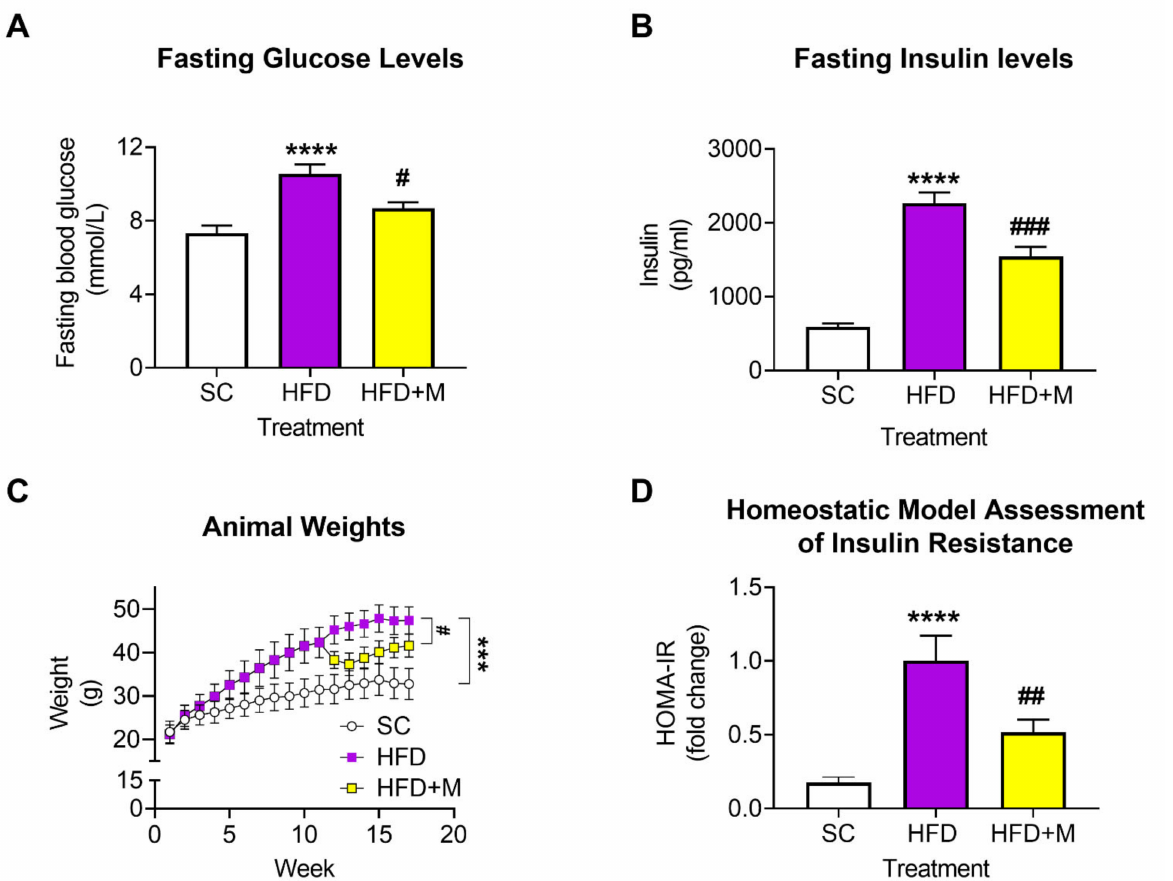
Figure 1. Fasting blood glucose and insulin levels, body weight, and insulin tolerance in mice fed with HFD and/or treated with metformin. ( A , B ) Fasting glucose and insulin levels were measured in animals fed with standard chow, HFD, or HFD plus metformin (300 mg/kg/BW, oral gavage) as per the manufacturer’s protocols. Tests were conducted after 5 h of fasting at the end of week 17. ( C ) Animal weights were monitored on a weekly basis and measurements were recorded. ( D ) Homeostatic model assessment for insulin resistance index (HOMA-IR) was calculated using the following equation, HOMA-IR = fasting glucose (mg/dL) × fasting insulin ( µ U/mL)/405. *** p < 0.001 or **** p < 0.0001 vs. SC; # p < 0.05, ## p < 0.01 or ### p < 0.001 vs. HFD, as determined by one-way ANOVA followed by Tukey’s post-hoc test. SC: Standard Chow, HFD: High Fat Diet, HFD + M: High Fat Diet +